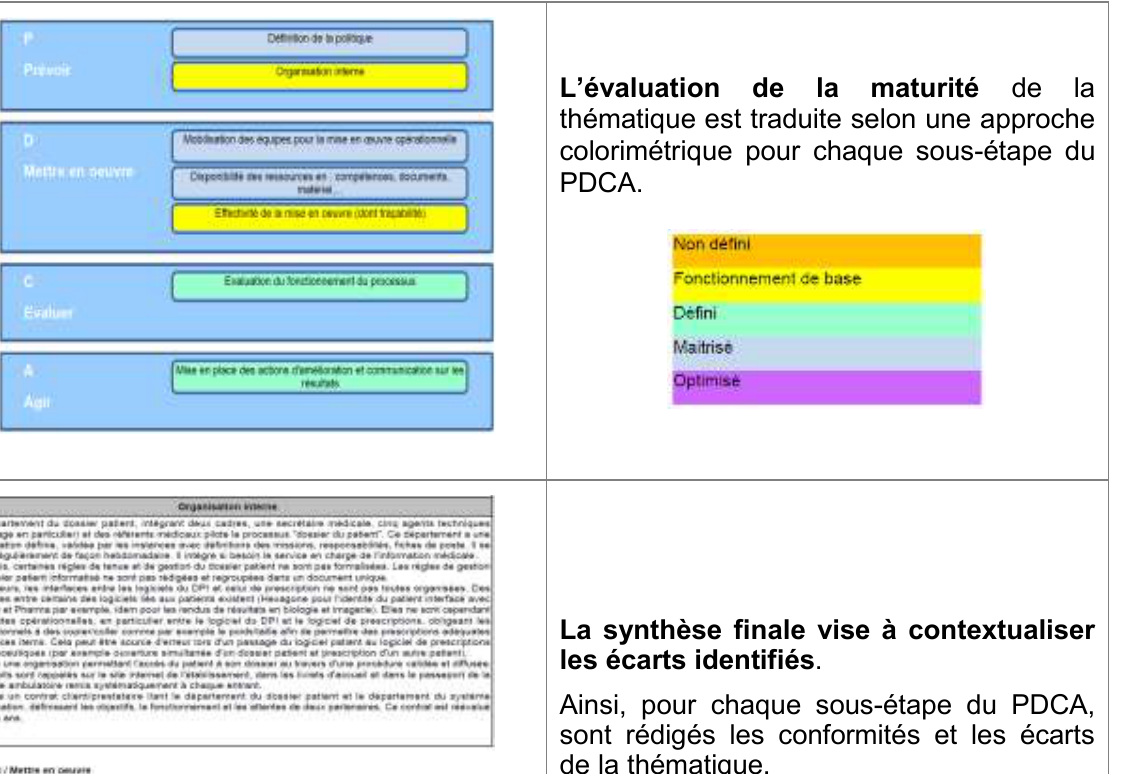
Le tableau des écarts énonce les écarts : - observés lors des audits de processus et des patients traceurs, - qualifiés, - rattachés au référentiel